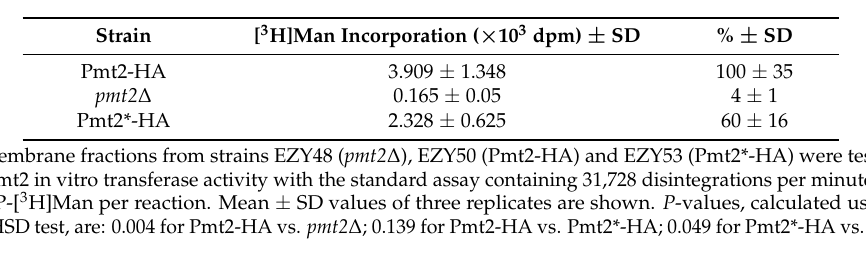
Table 2. Mannosyltransferase activity in